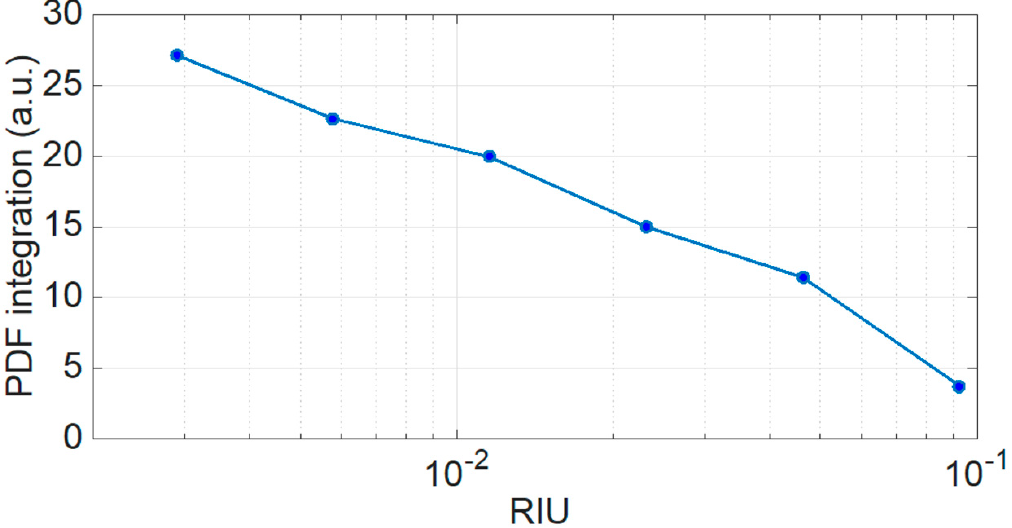
Figure 8. Result of integration of PDF, estimated by the wavelet operator for each variation of refractive index, reported in logarithmic units.